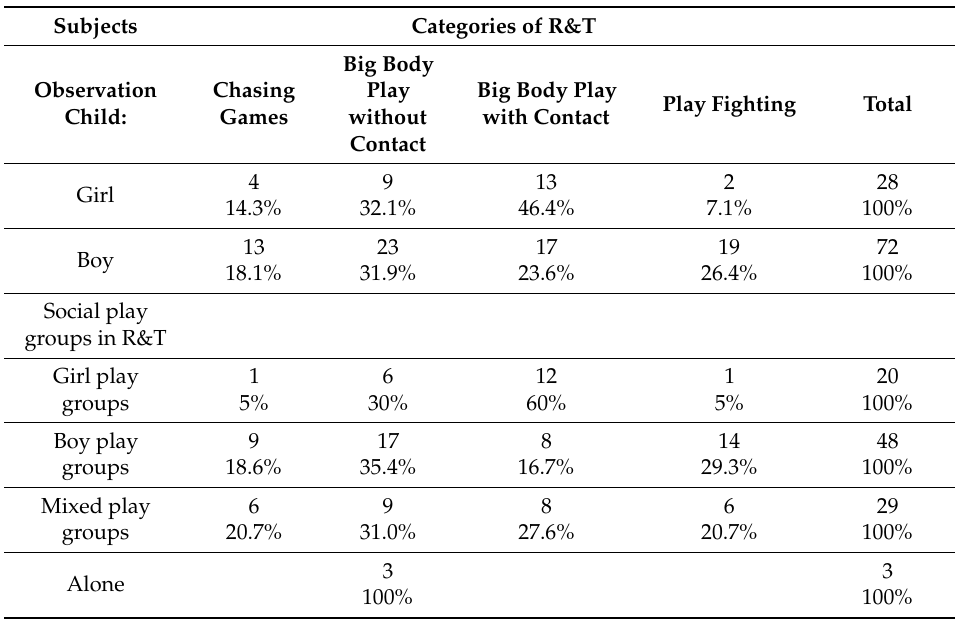
Table 1. Distribution of categories of children’s R&T related to the gender of the observation child and social